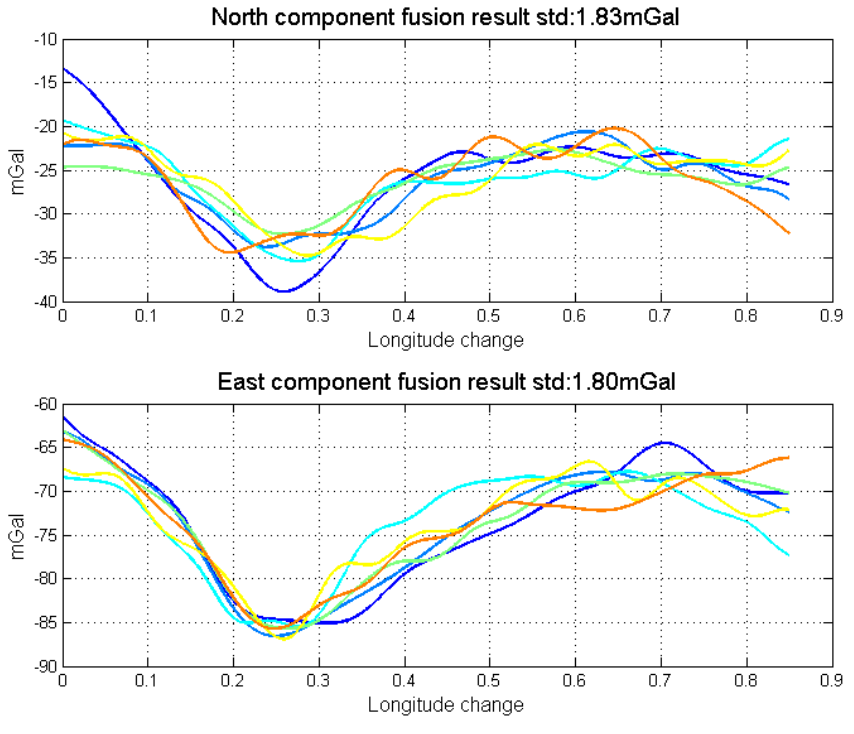
Figure 19. Data fusion results by the accuracy improvement